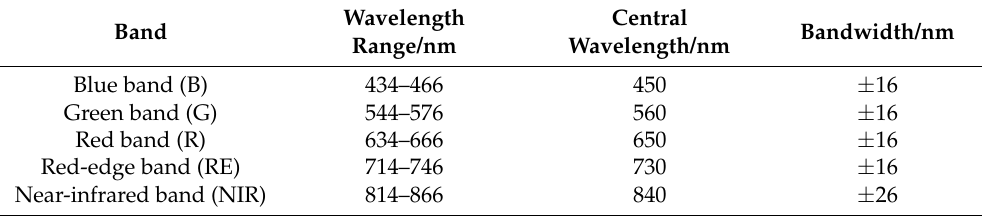
Table 1. Multispectral camera parameters.